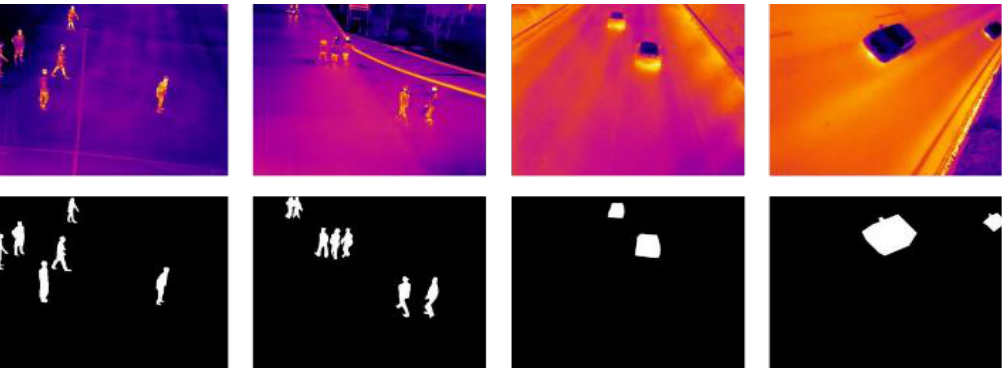
Figure 4. Sample annotations from pedestrian and vehicle thermal dataset. Top: Original images. Bottom: Pixel level annotations.